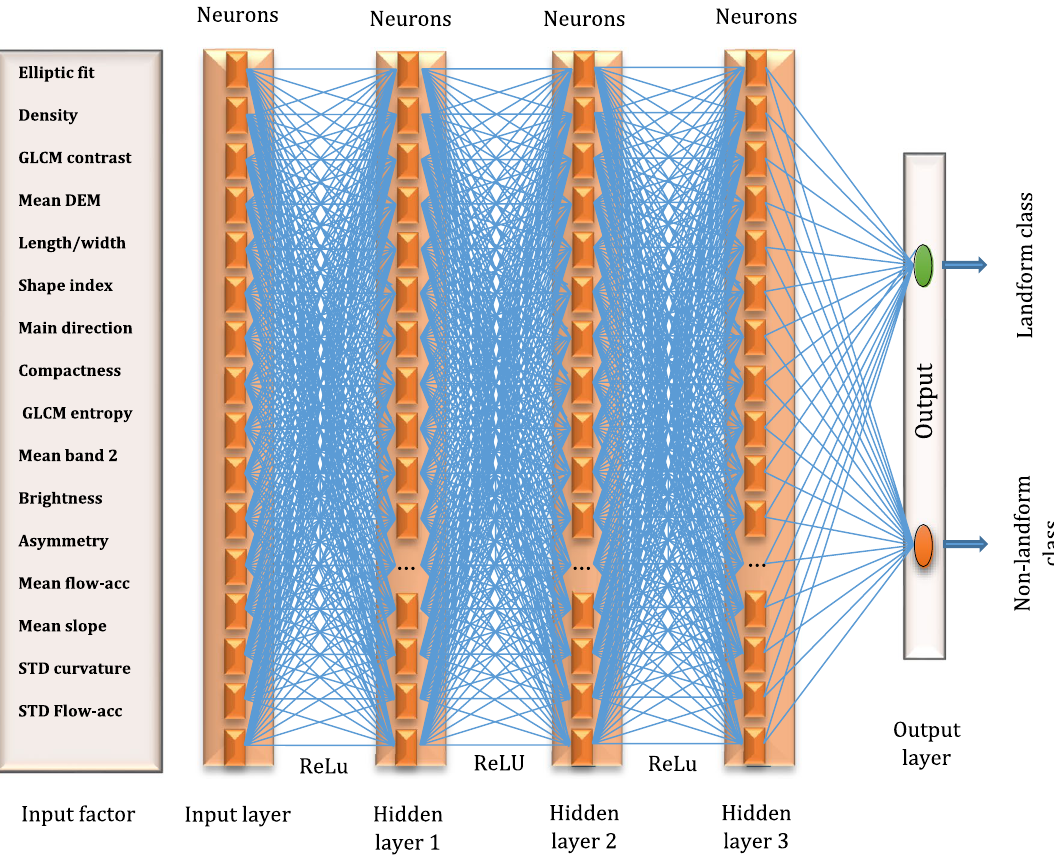
Figure 6. CNN structure for volcanic and glacial